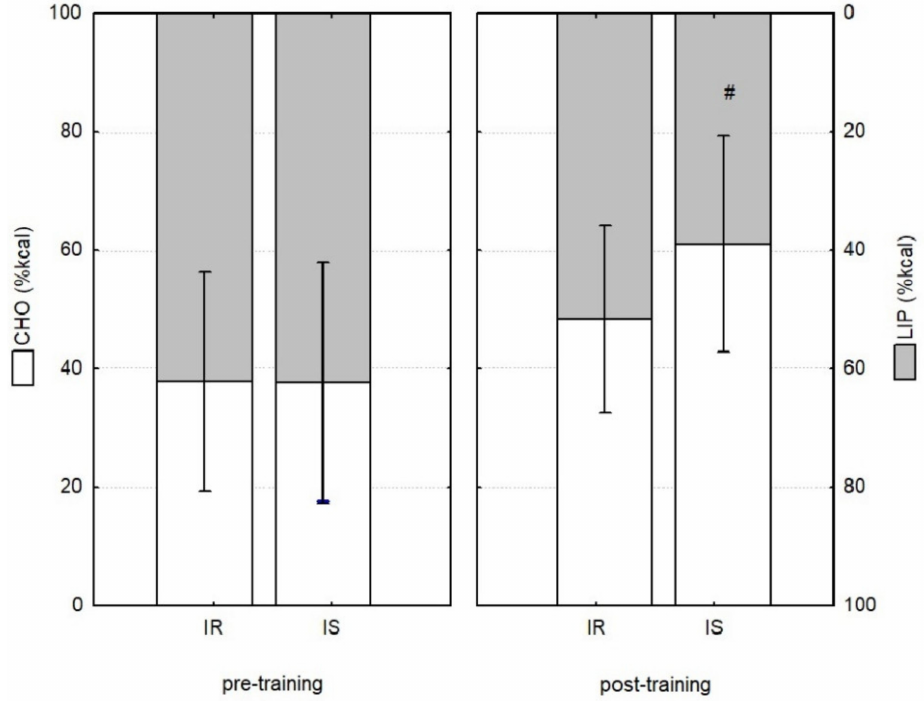
Figure 2. Energy derived from carbohydrates (CHO) and lipids (LIP) pre-and post-training. Mean values ± standard deviation; insulin-resistant (IR, n = 13) and insulin-sensitive (IS, n = 12). # Indicates p < 0.05 versus the period pre-training in the same